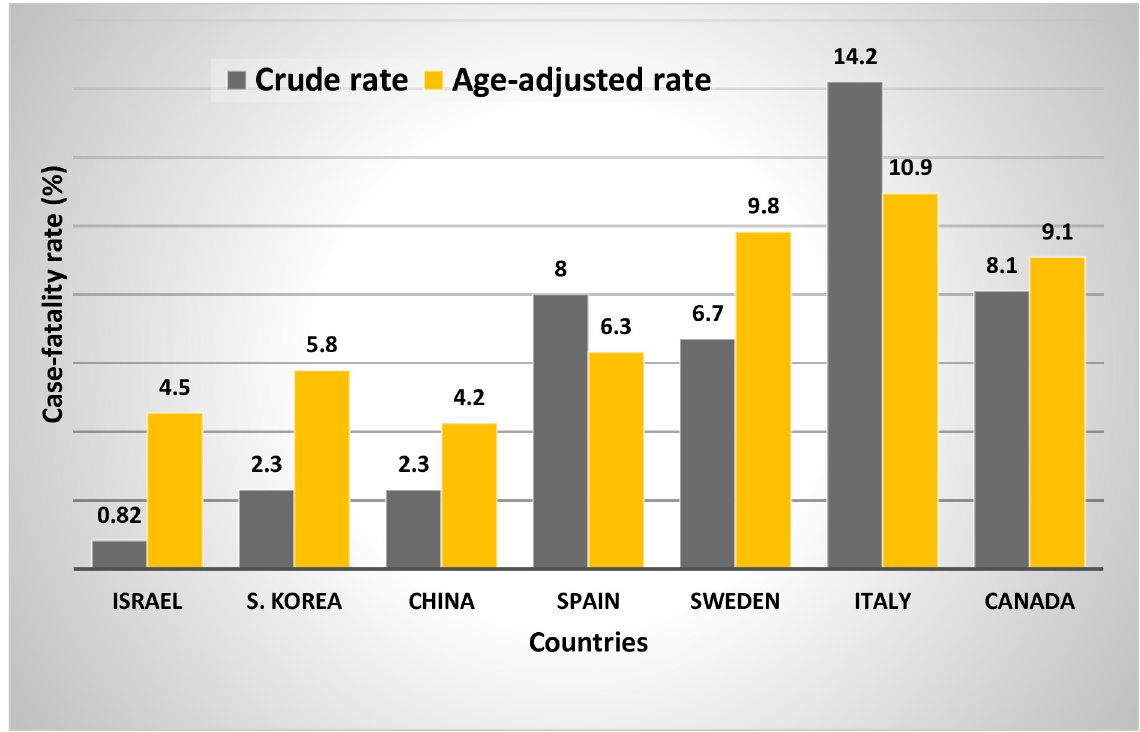
Fig 3. Crude (%) and age-adjusted case-fatality rates (%) by country for seven